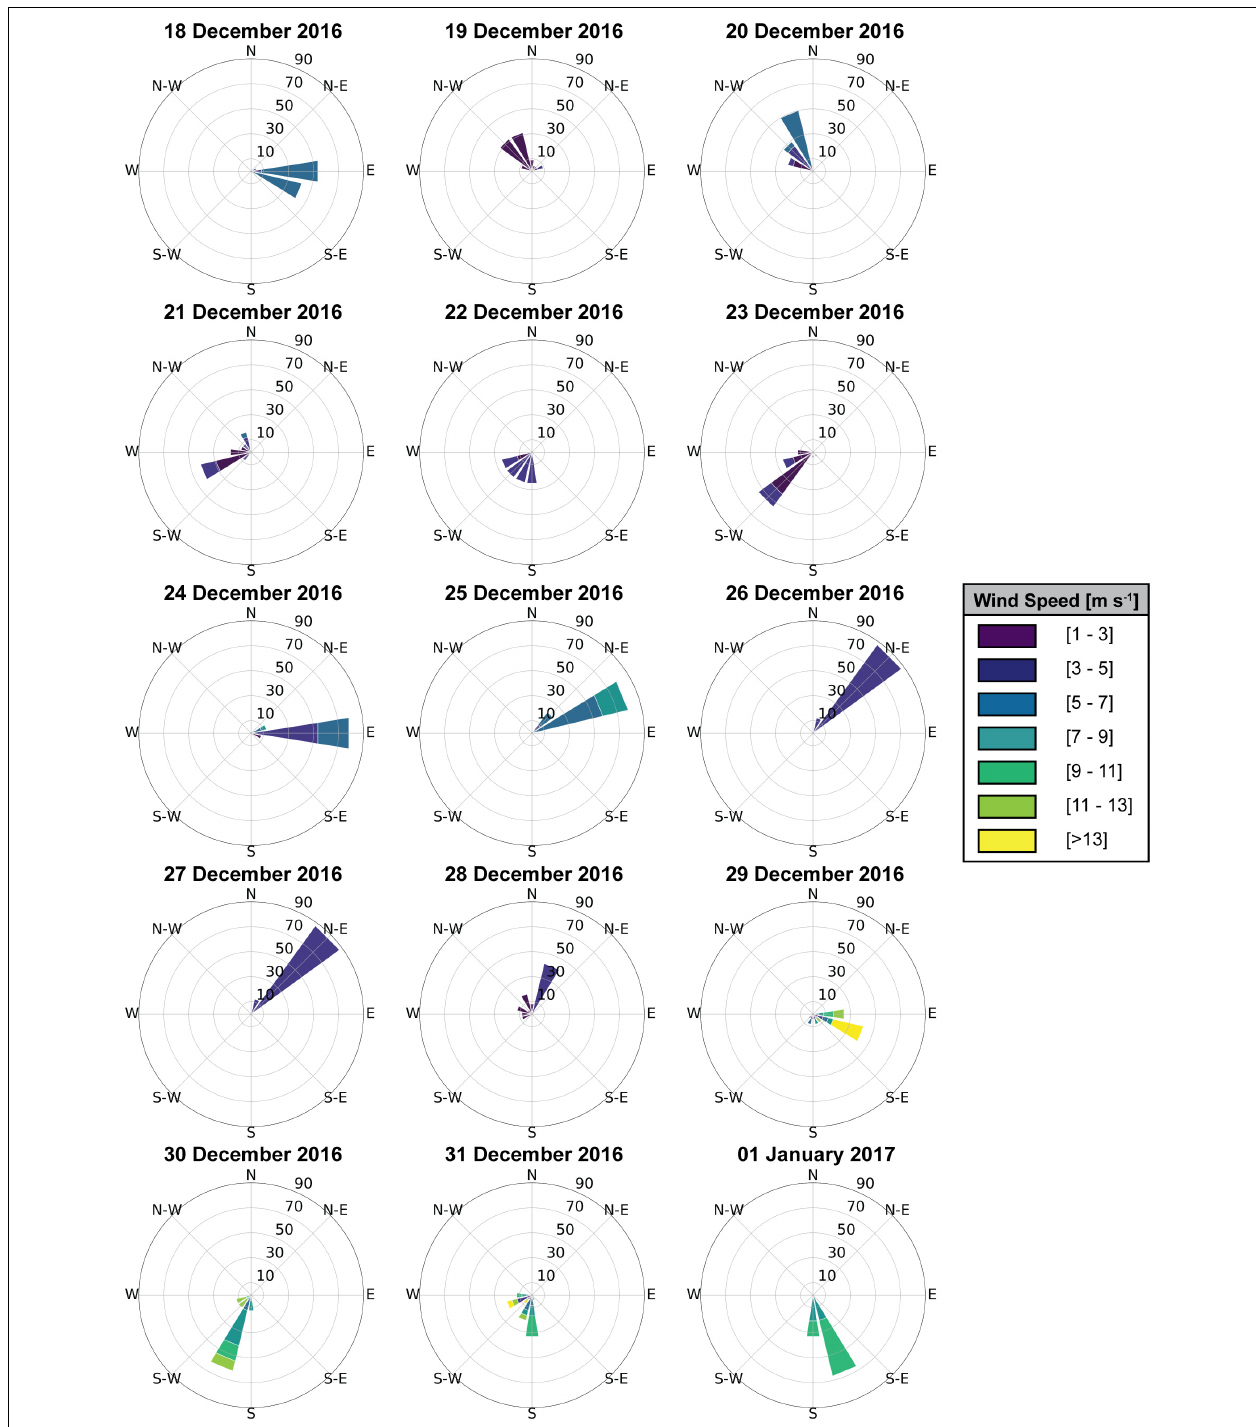
FIGURE 7 | Wind rose diagrams derived from the ERA-5 atmospheric reanalysis provided by the European Centre for Medium-Range Weather Forecasts (ECMWF) between 18 December 2016, and 1 January 2017. Wind at 10 m altitude from one ERA-5 cell at the Cape (66.5500 ◦ N, –163.6400 ◦ W) is shown. The circular format of the wind rose shows the direction the winds blew from and the length of each “spoke” around the circle shows how often the wind blew from that direction (here we use a fixed scale up to 90%). The different colors of each spoke provide details on the speed, in m s - 1 , of the wind toward each direction. Notice the northwesterly winds on 19 and 20 December, which accompanied the low-pressure system and developed the open-water lead south of the Cape. Easterly and/or northeasterly winds between 24 and 29 December kept the ice pack within Kotzebue Sound pushed up against the western shore, south of the Cape. Southerly winds between 30 December and 1 January, combined with significant surge, resulted in the ice push event at Cape Espenberg.